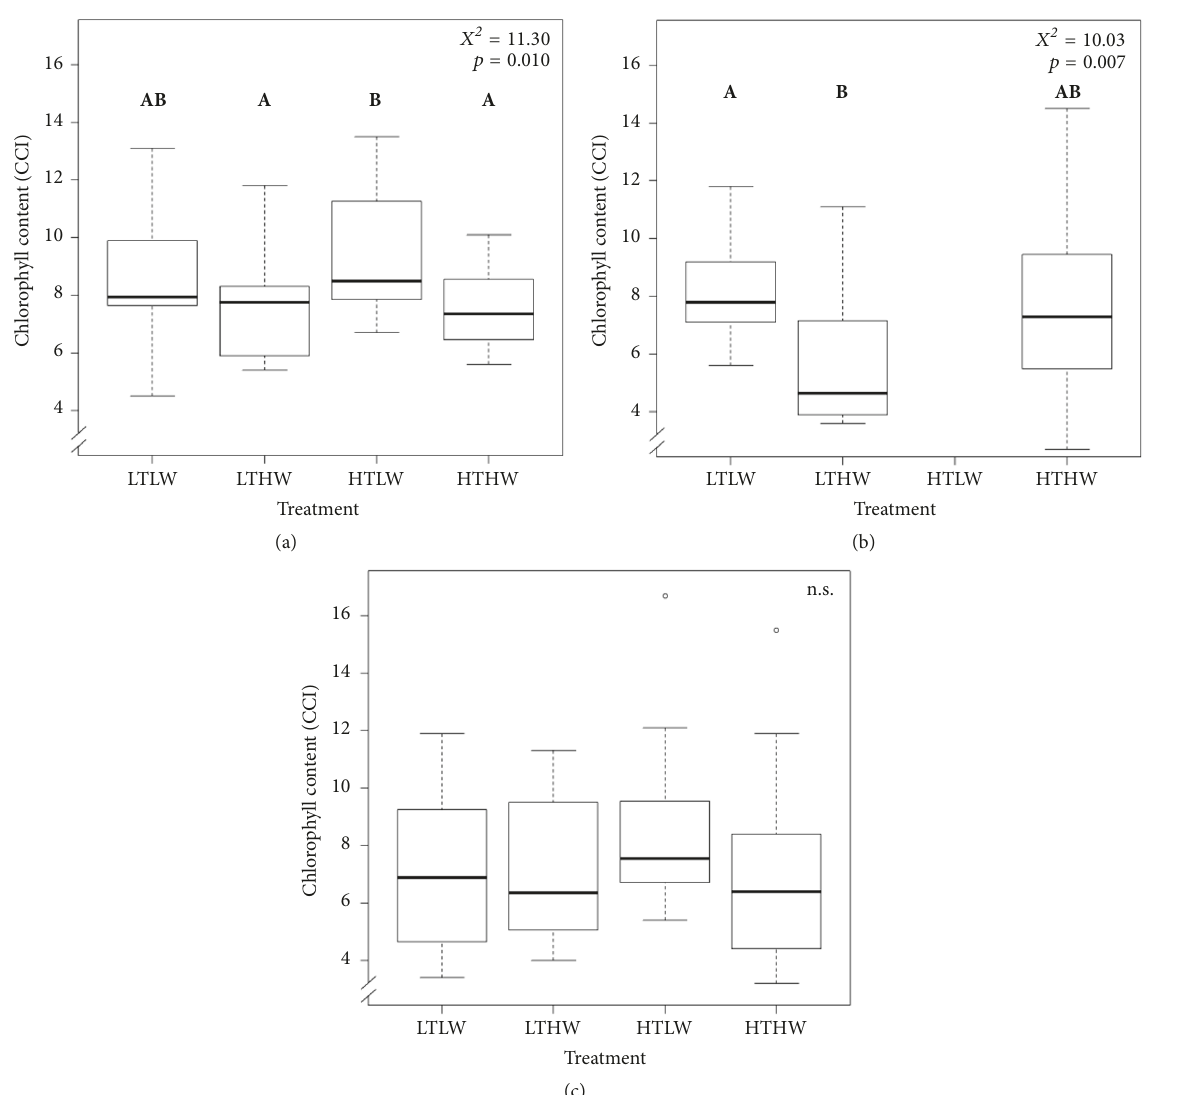
Figure3:Chlorophyllcontentof(a) Fagussylvatica (n=20),(b) Acerpseudoplatanus (n=15),and(c) Carpinusbetulus (n=20)forthedifferent treatments in the greenhouse experiment. Boxplots are marked with uppercase letters indicating significant differences using Kruskal-Wallis and post hoc test ( p < 0.05; df = 3) or with “n.s.” for nonsignificant differences. Treatments: LTLW, lower temperature and lower irrigation; LTHW, lower temperature and higher irrigation; HTLW, higher temperature and lower irrigation; HTHW, higher temperature and higher